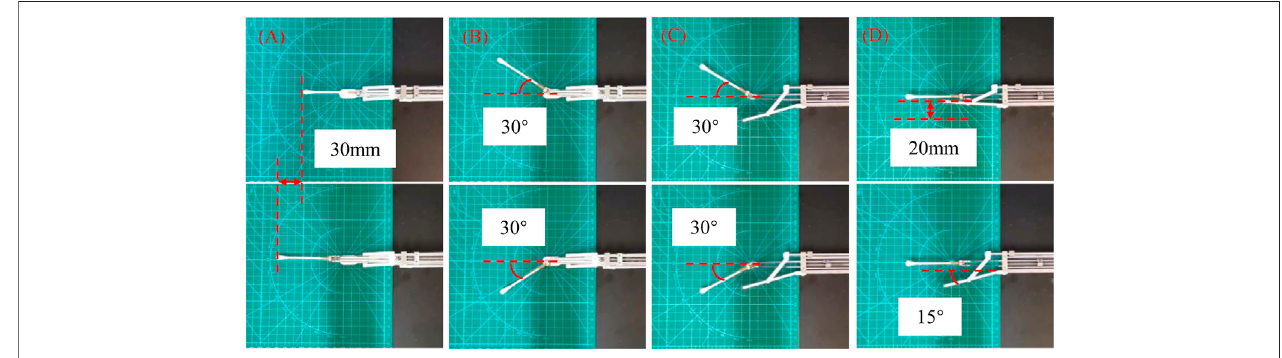
FIGURE 2 | Workspace demonstration of the robot. (A) The maximum displacement; (B) The maximum bending angle in top view; (C) The maximum bending angle in side view; (D) The motion range of the tongue